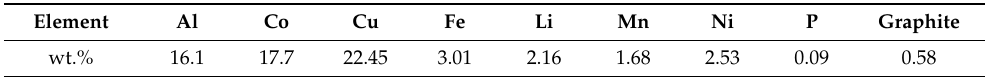
Table 5. The chemical composition of froth flotation underflow.